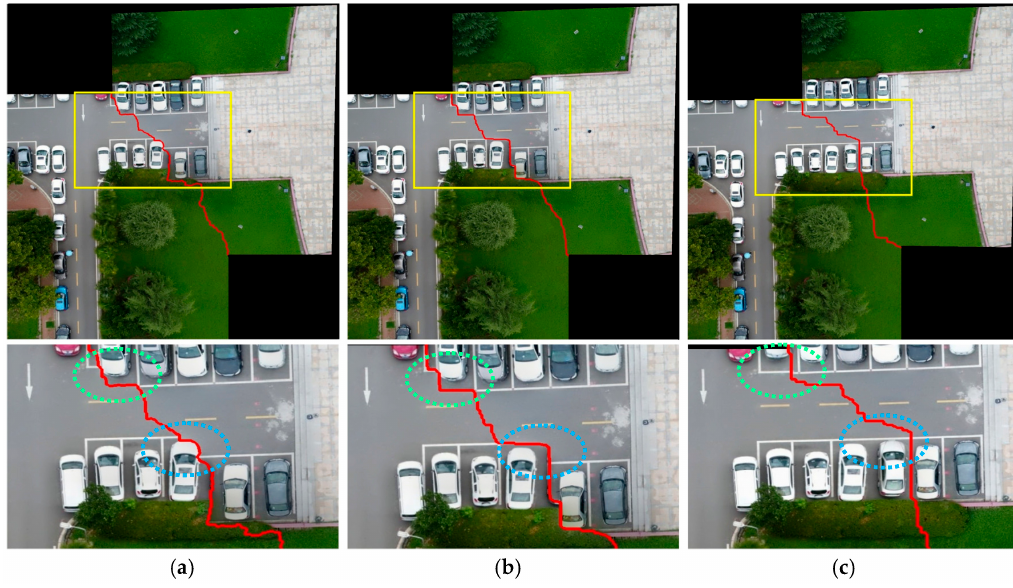
Figure 8. Optimal seam-lines of three test methods for Figure 5b. ( a ) GCC. ( b ) GCCG. ( c ) GCCGOF.